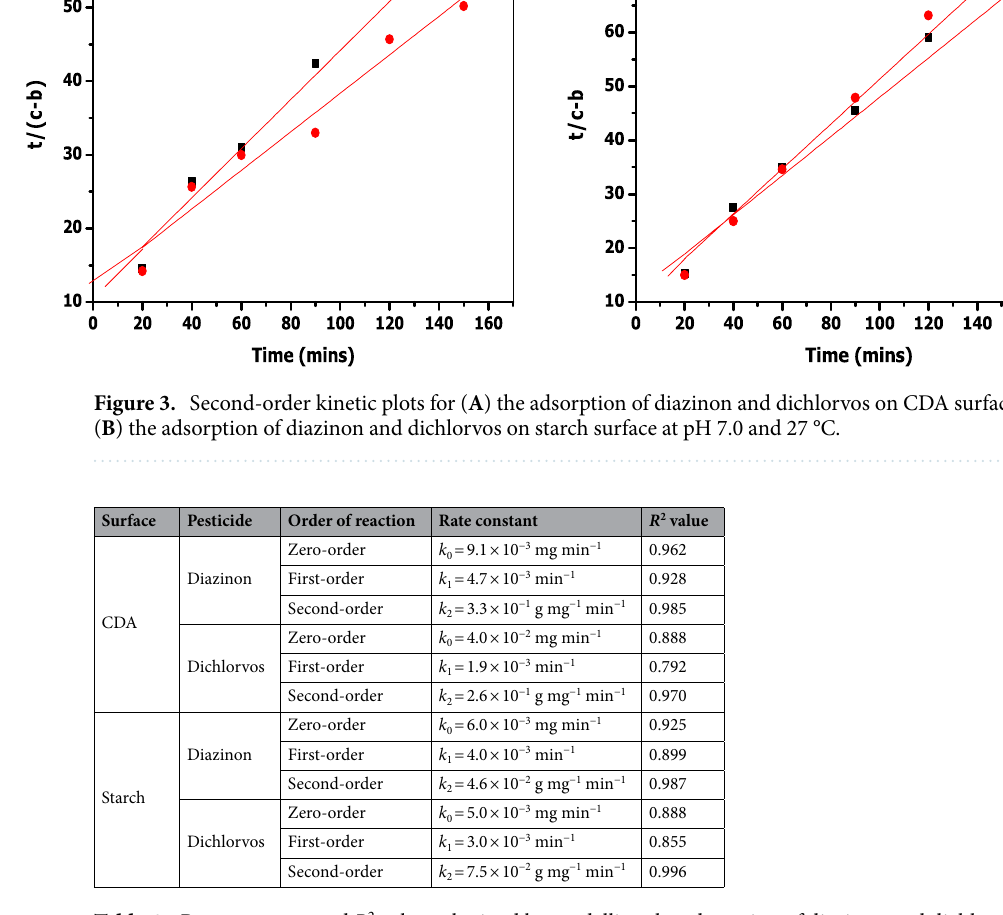
Table 4. Rate constants and R 2 values obtained by modelling the adsorption of diazinon and dichlorvos on CDA and starch surfaces at pH 7.0 and 27